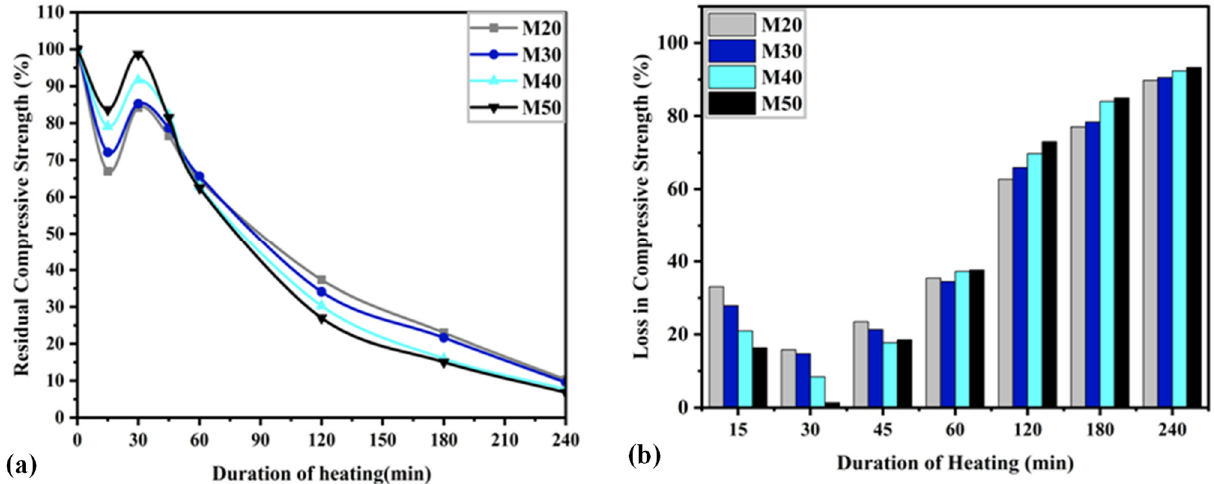
Figure 5. ( a ) Residual CS of concrete, ( b ) loss of CS of concrete.